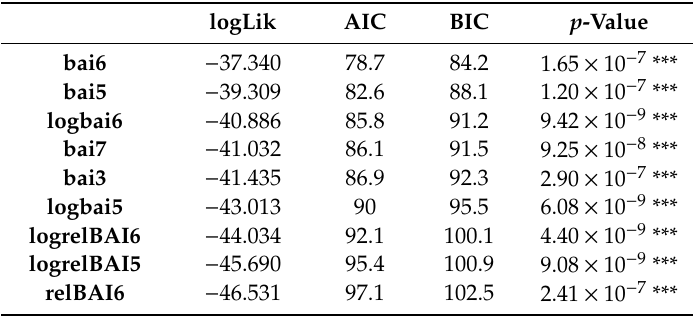
Table 3. Best models with one explanatory variable: Growth level, ranked according to Akaike information criterion (AIC) value.